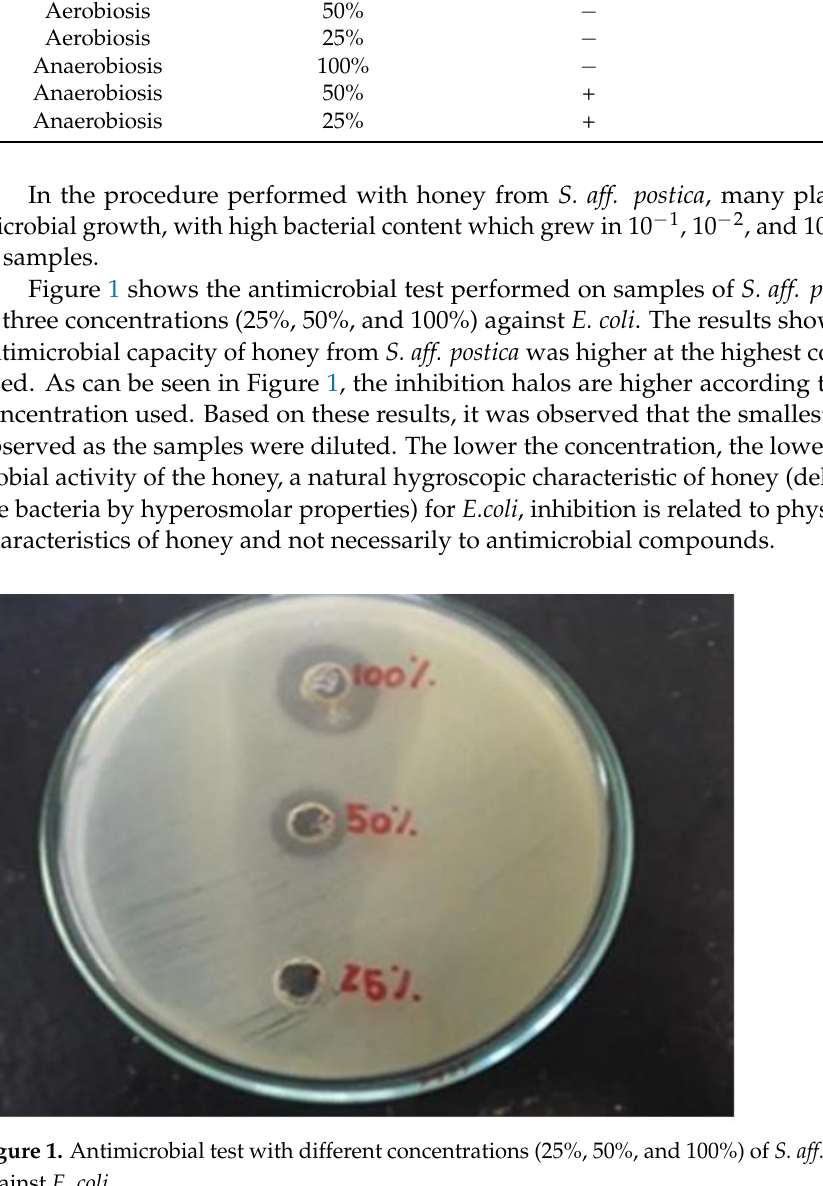
Table 1. Microbial growth of A. mellifera honey samples on MRS Agar for aerobic and anaero- bic processes.